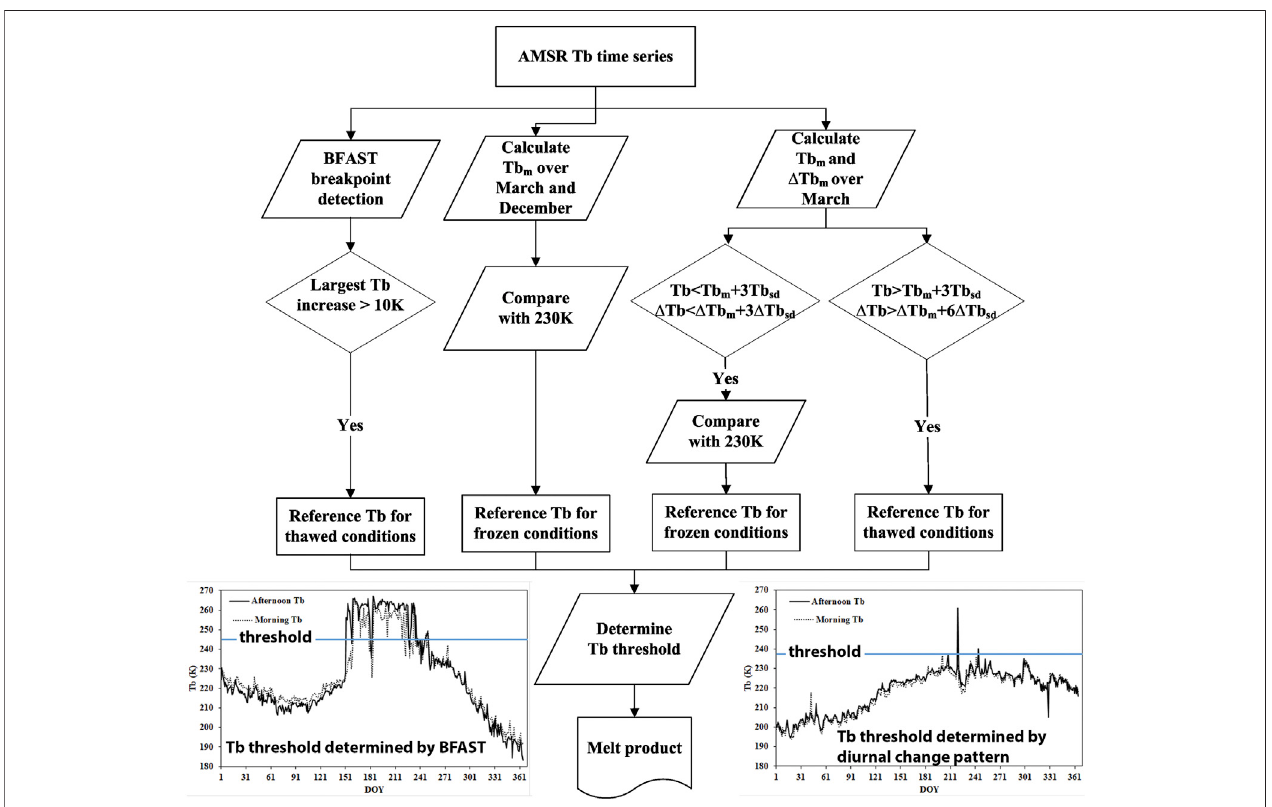
FIGURE 1 | Processing fl owchart for Adaptive Threshold (ADT)